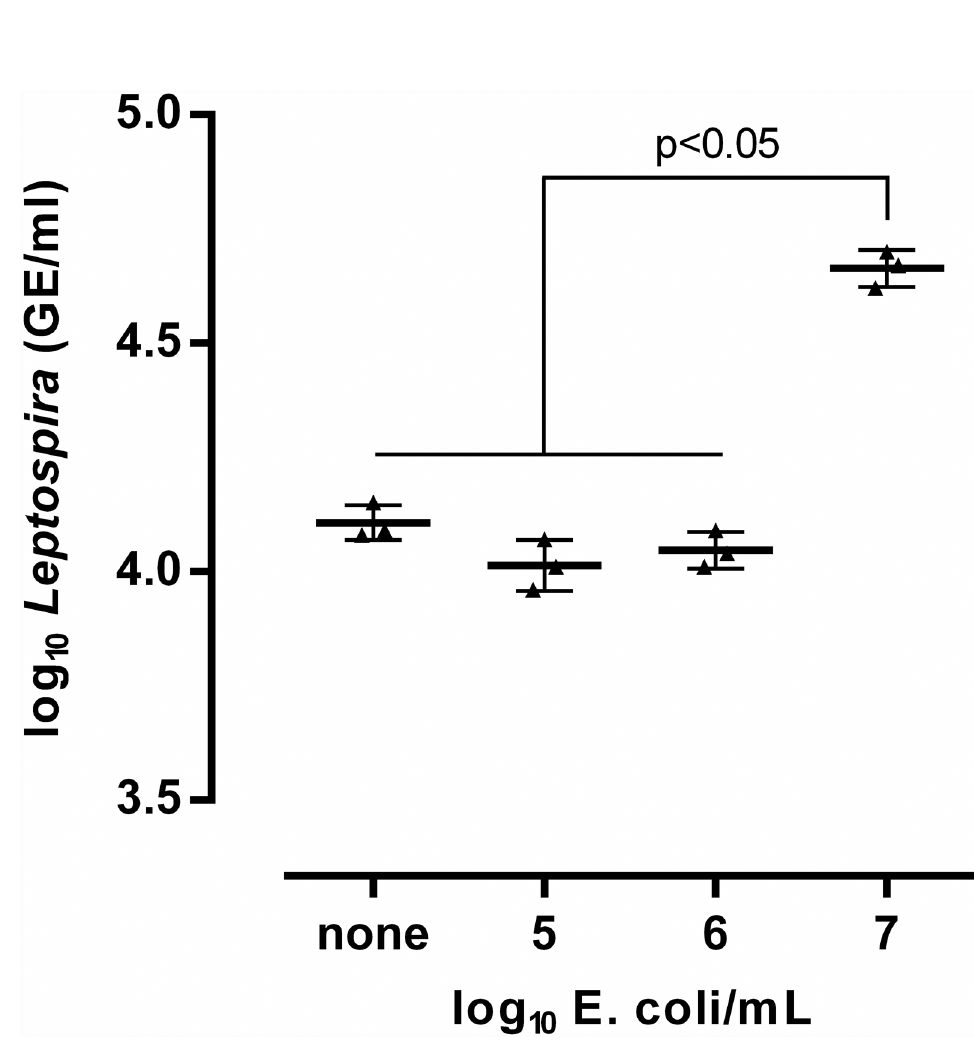
Fig 1. Effect of the addition of varying amounts of E . coli on Leptospira recovery from ultrapure water. Aliquots were spiked with 1 × 10 5 Leptospira /mL and with 1 × 10 5 , 1 × 10 6 and 1 × 10 7 E . coli /mL. Ultrapure water spiked with 1 × 10 5 Leptospira /mL was used as negative control. Error bars represent the geometric mean ± SD of the concentrations as determined by qPCR in three independent experiments.